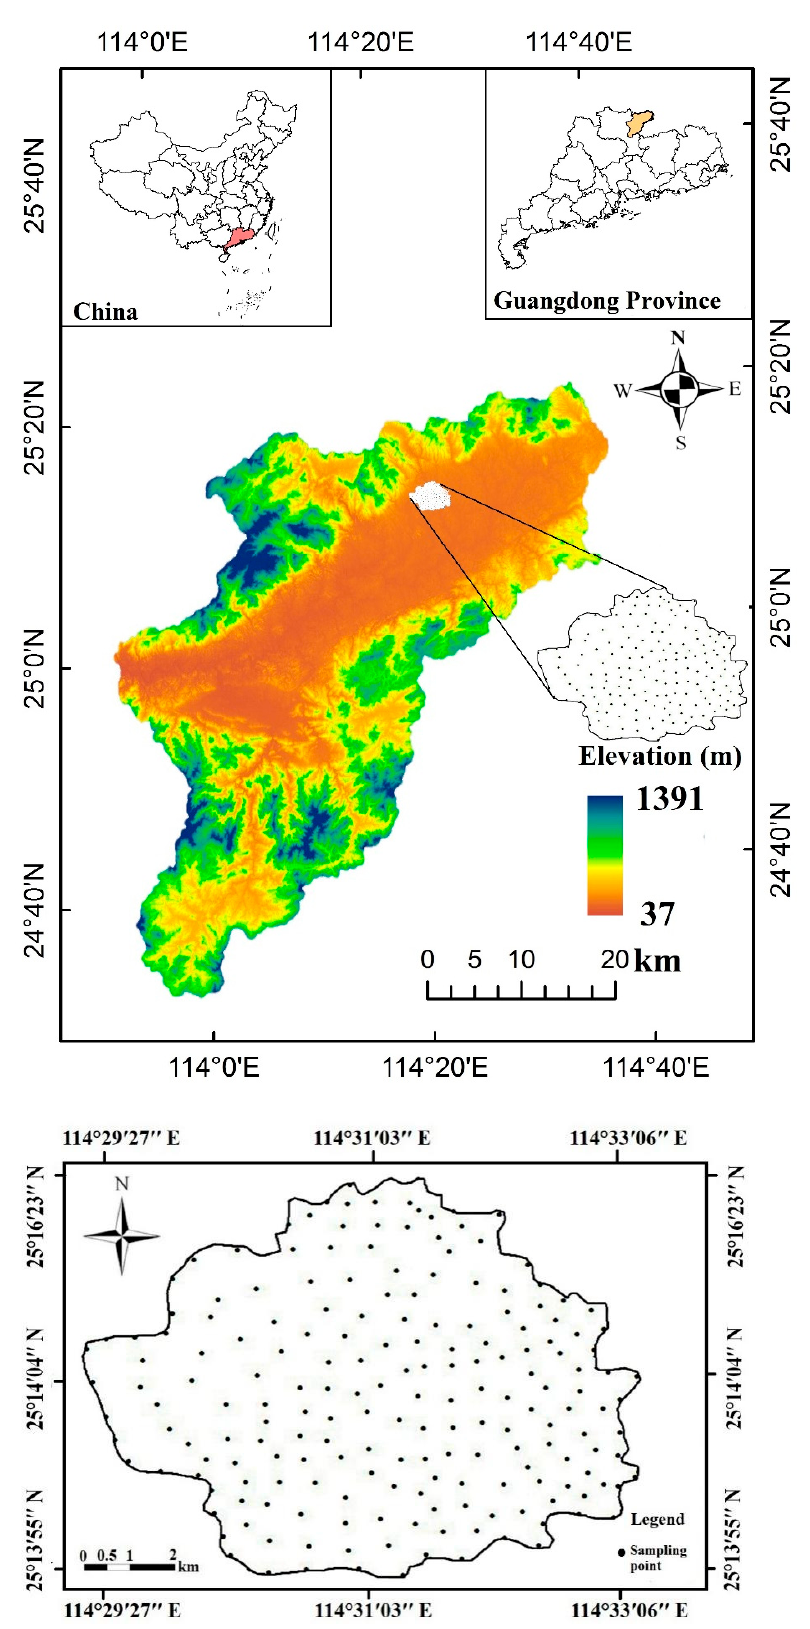
Figure 1. Location of the study area and distribution of soil sampling sites.